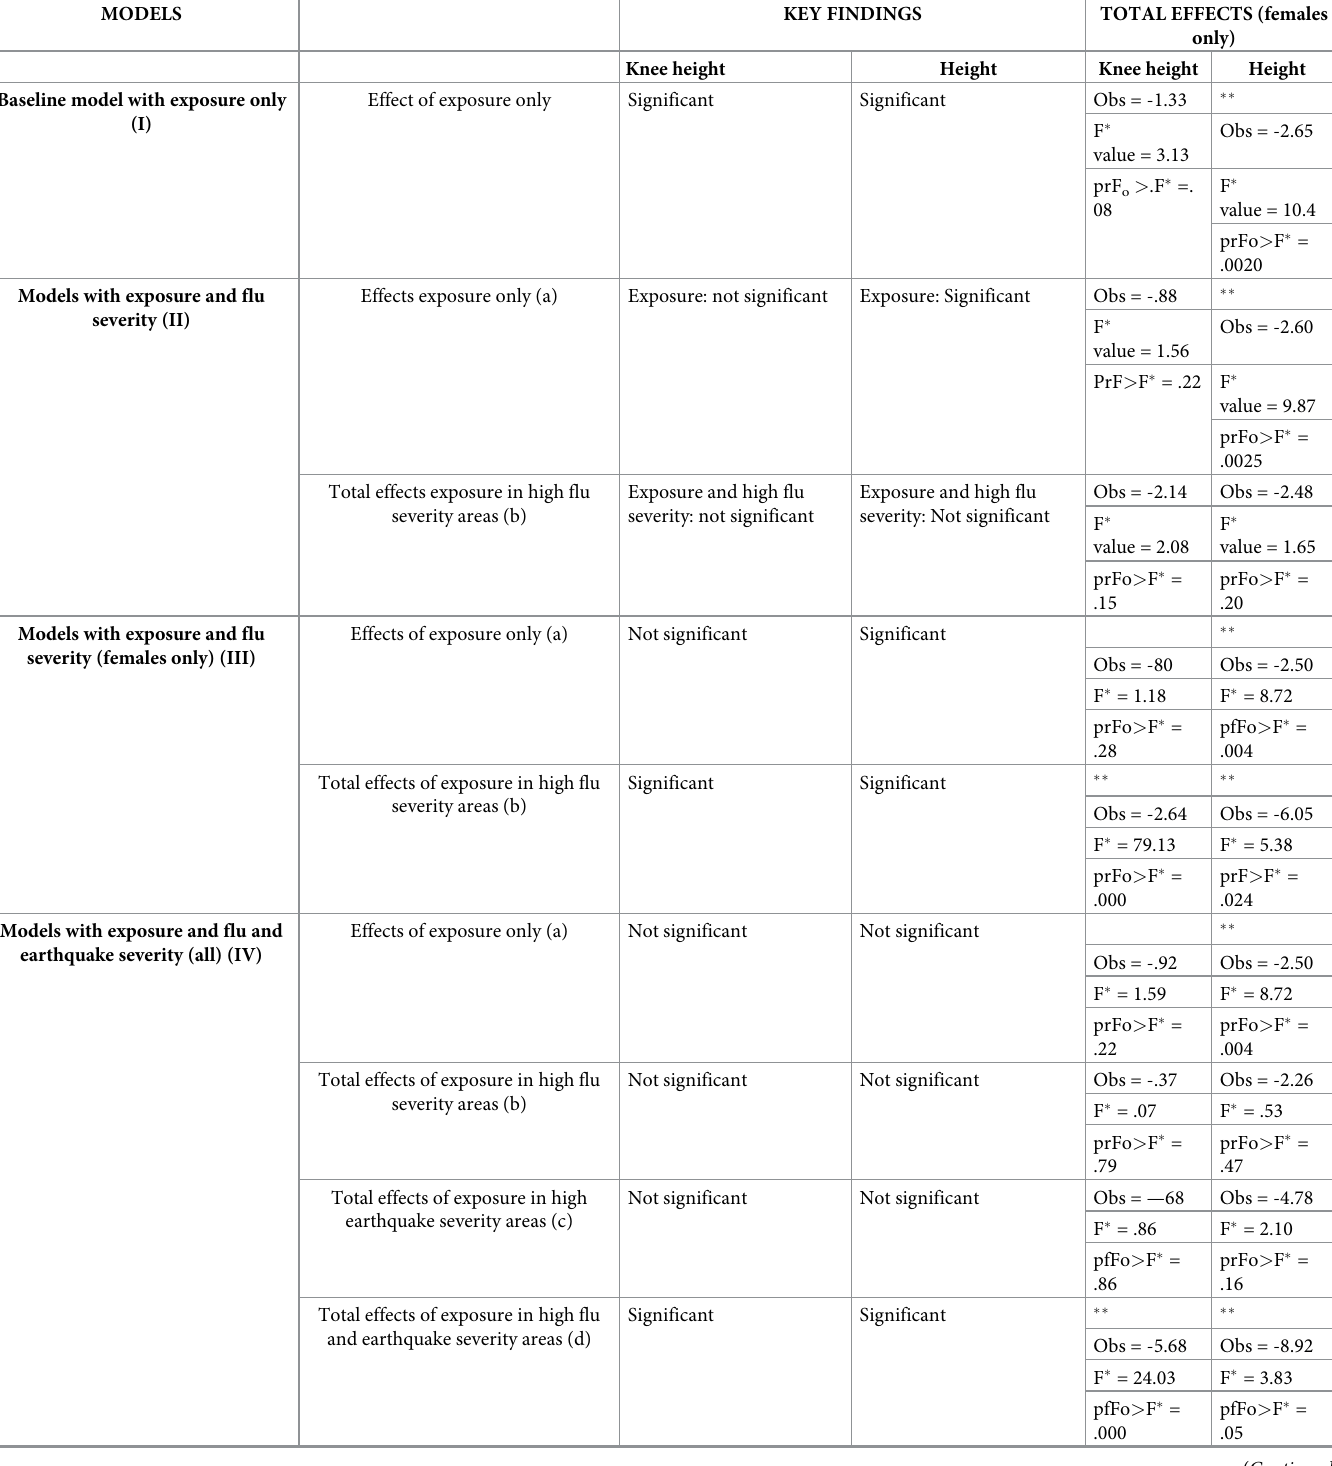
Table 7. Synthesis of